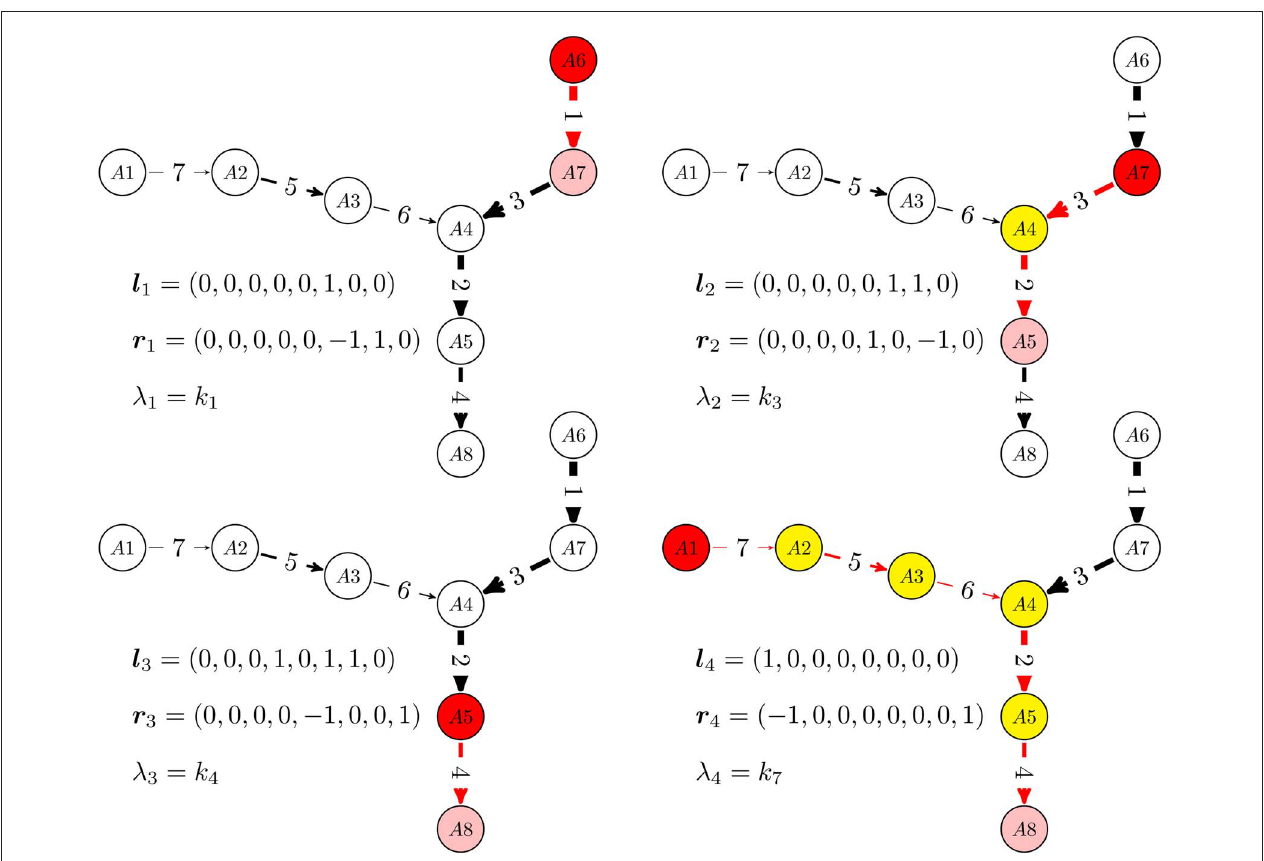
FIGURE 2 | Relaxation modes of linear multiscale networks. For a given timescale, monomolecular networks with total separation behave as a single step: the concentrations of some species (white) are practically constant, some species (yellow) are rapid, low concentration, intermediates, one species (red) is gradually consumed and another (pink) is gradually produced.